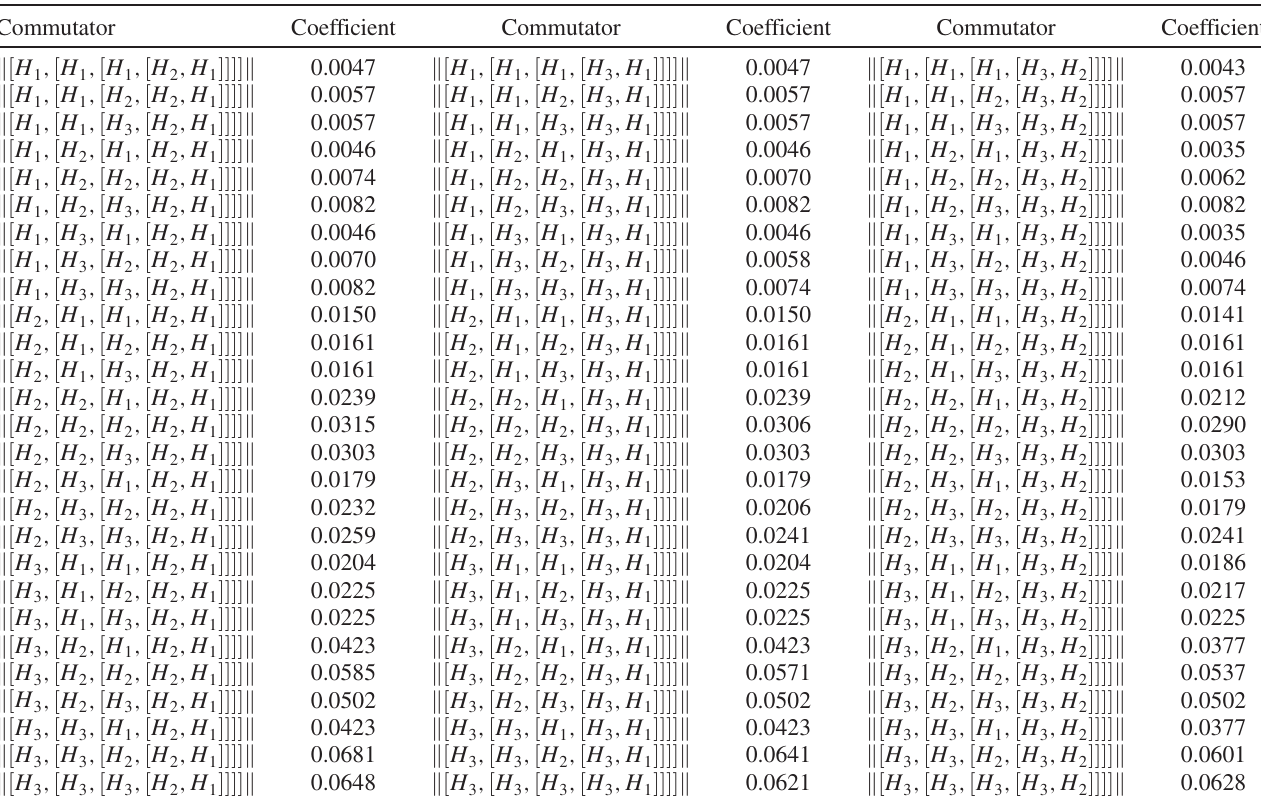
TABLE II. Coefficients of the fourth-order Trotter error bound [Eq. (M14)] for Hamiltonians with three